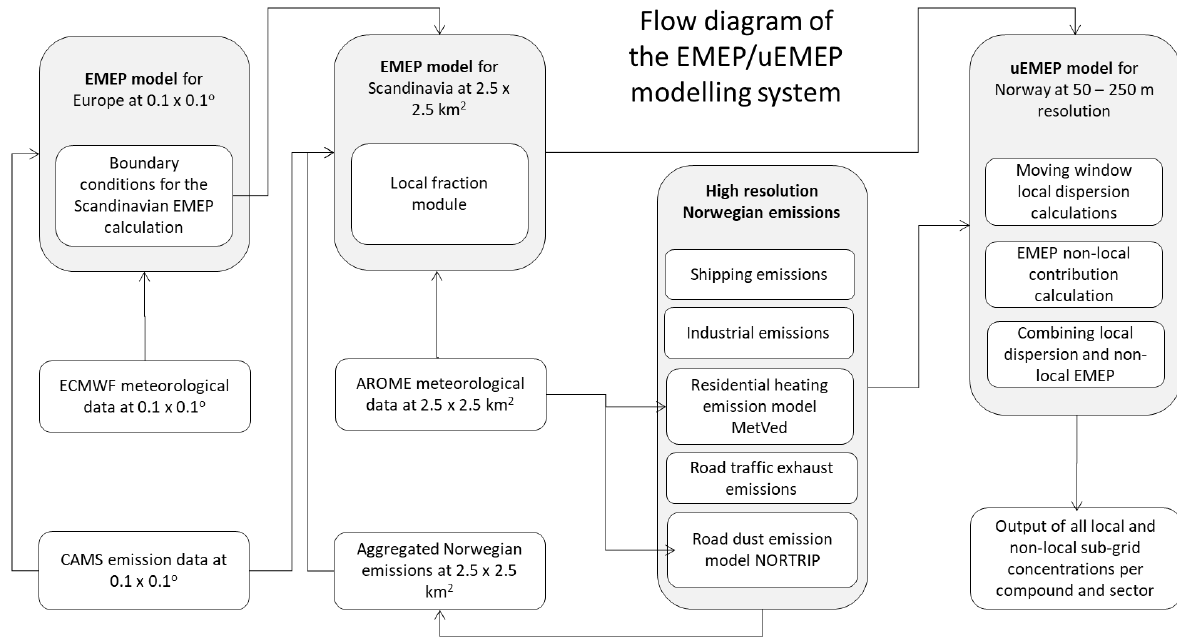
Figure 6. Flow diagram showing the various components of the Norwegian EMEP/uEMEP forecast system.